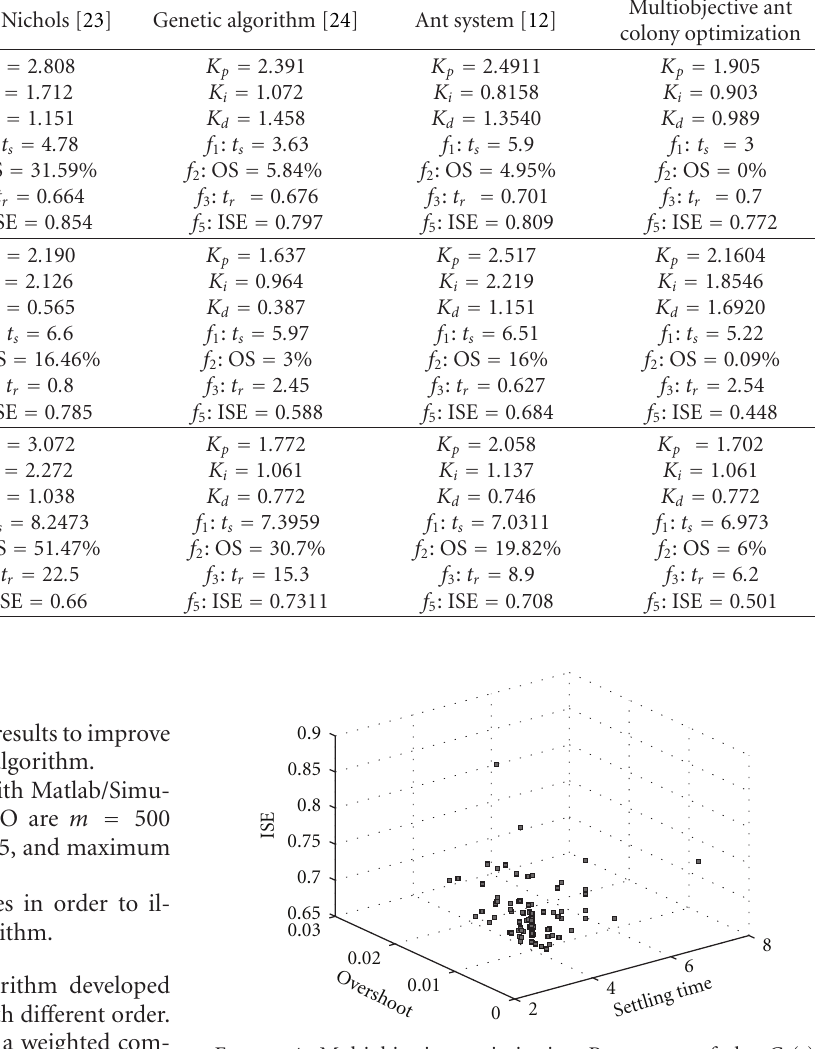
Figure 4: Multiobjective optimization Pareto-sets of the G 1 ( s )